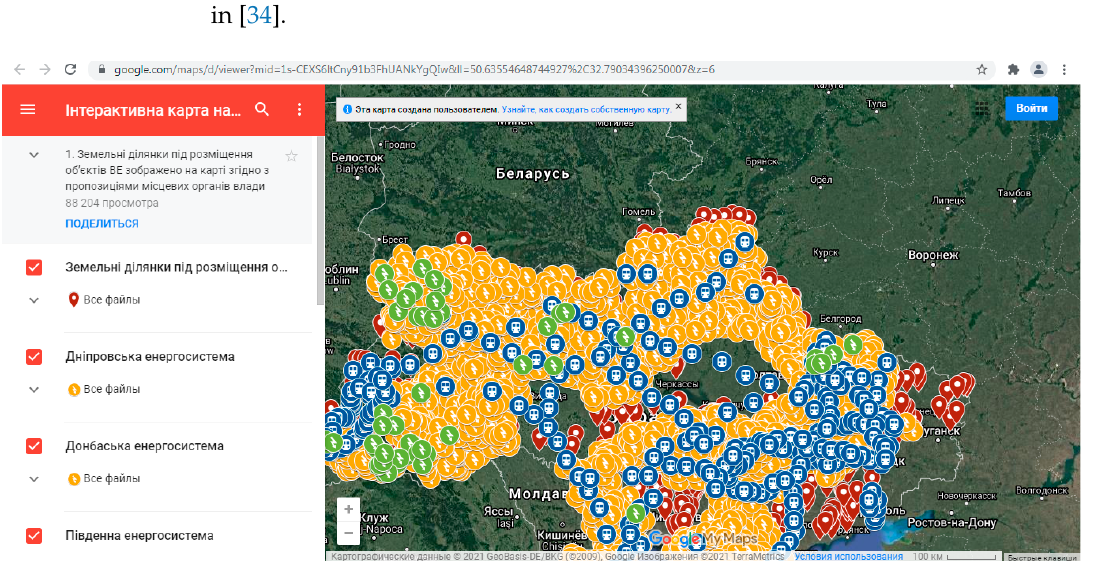
Figure 6. Interactive investment resource map of Ukraine “UA MAP” (reproduction of graphic material from [34]).